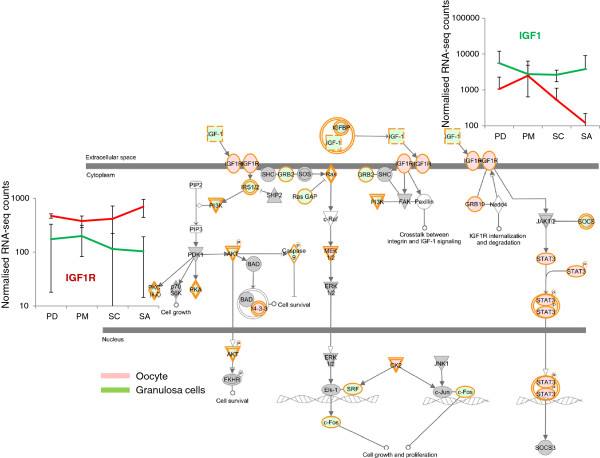
IGF signaling pathway. Gene expression involved in the IGF1 signaling pathway. Genes in red are over expressed in oocytes. Genes in green are over expressed in GCs. Relative expression of IGF1 and IGF1R from RNAseq data in the graph. The Y axis corresponds to RNA-seq normalized read counts.